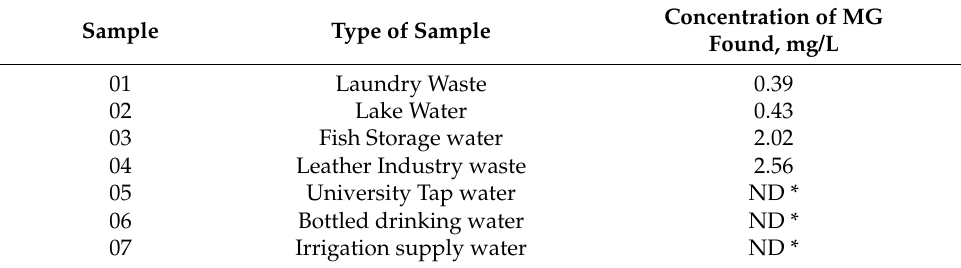
Table 5. Determination of MG in different environmental